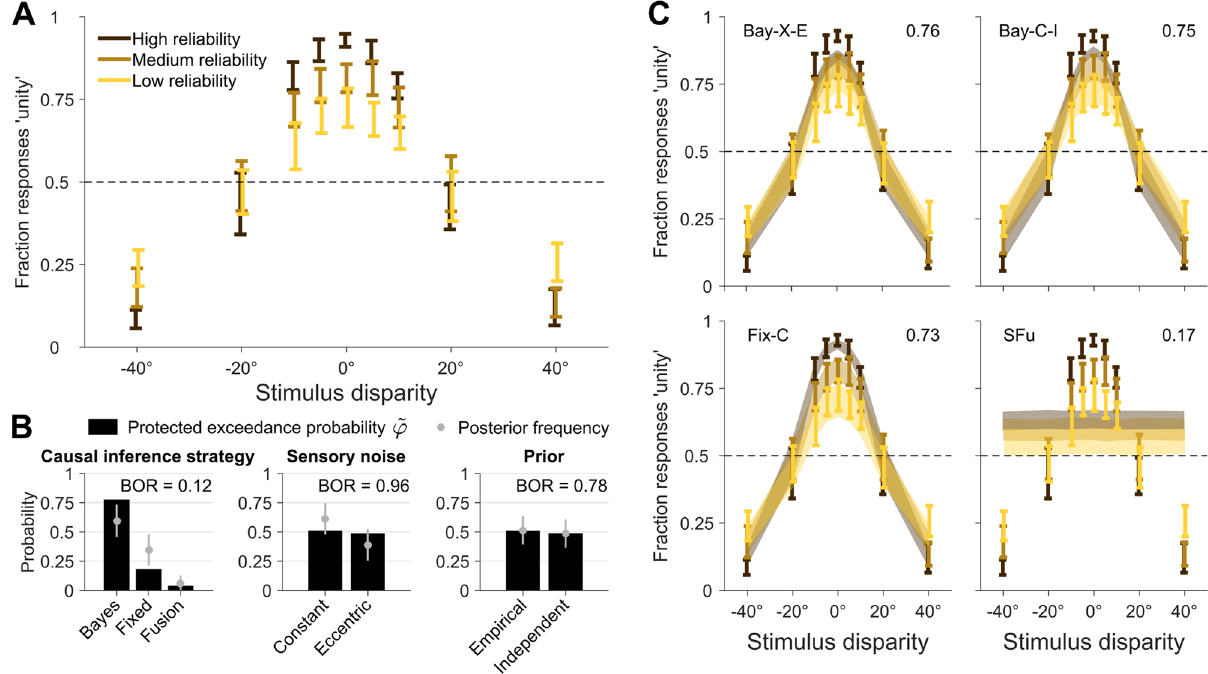
Fig 3. Explicit causal inference. Results of the explicit causal inference (unity judgment) task. A : Proportion of ‘unity’ responses, as a function of stimulus disparity (difference between vestibular and visual heading direction), and for different levels of visual cue reliability. Bars are ± 1 SEM across subjects. Unity judgments are modulated by stimulus disparity and visual cue reliability. B : Protected exceedance probability ~ φ and estimated posterior frequency (mean ± SD) of distinct model components for each model factor. Each factor also displays the Bayesian omnibus risk (BOR). C : Model fits of several models of interest (see text for details). Shaded areas are ± 1 SEM of model predictions across subjects. Numbers on top right of each panel report the absolute goodness of fit.